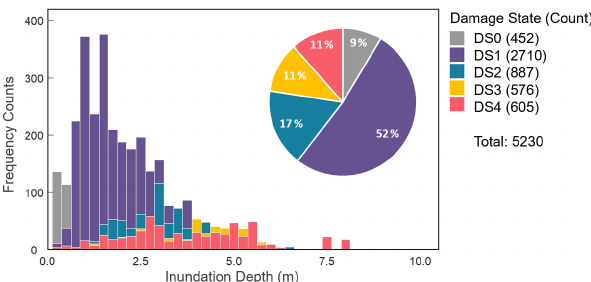
Figure 5. Histograms of each damage state. Distribution of damage data indicates non-normality, and DS 1 accounts for the majority of the